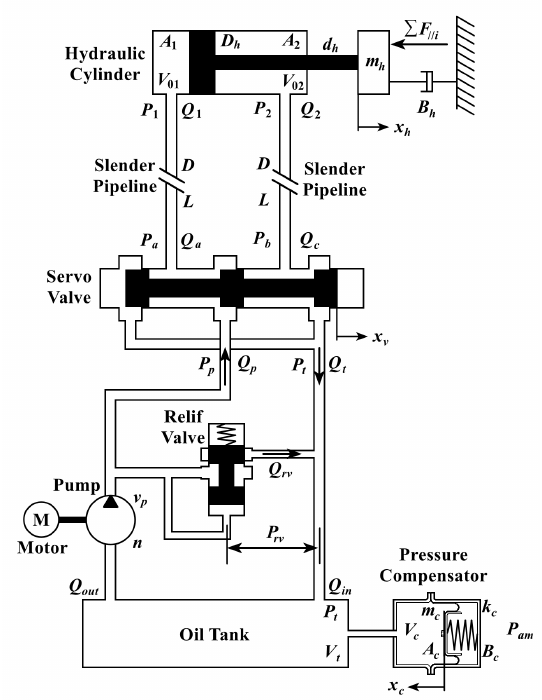
Figure 1. Schematic diagram of a deep-sea VCHCS with a pressure compensator and slender